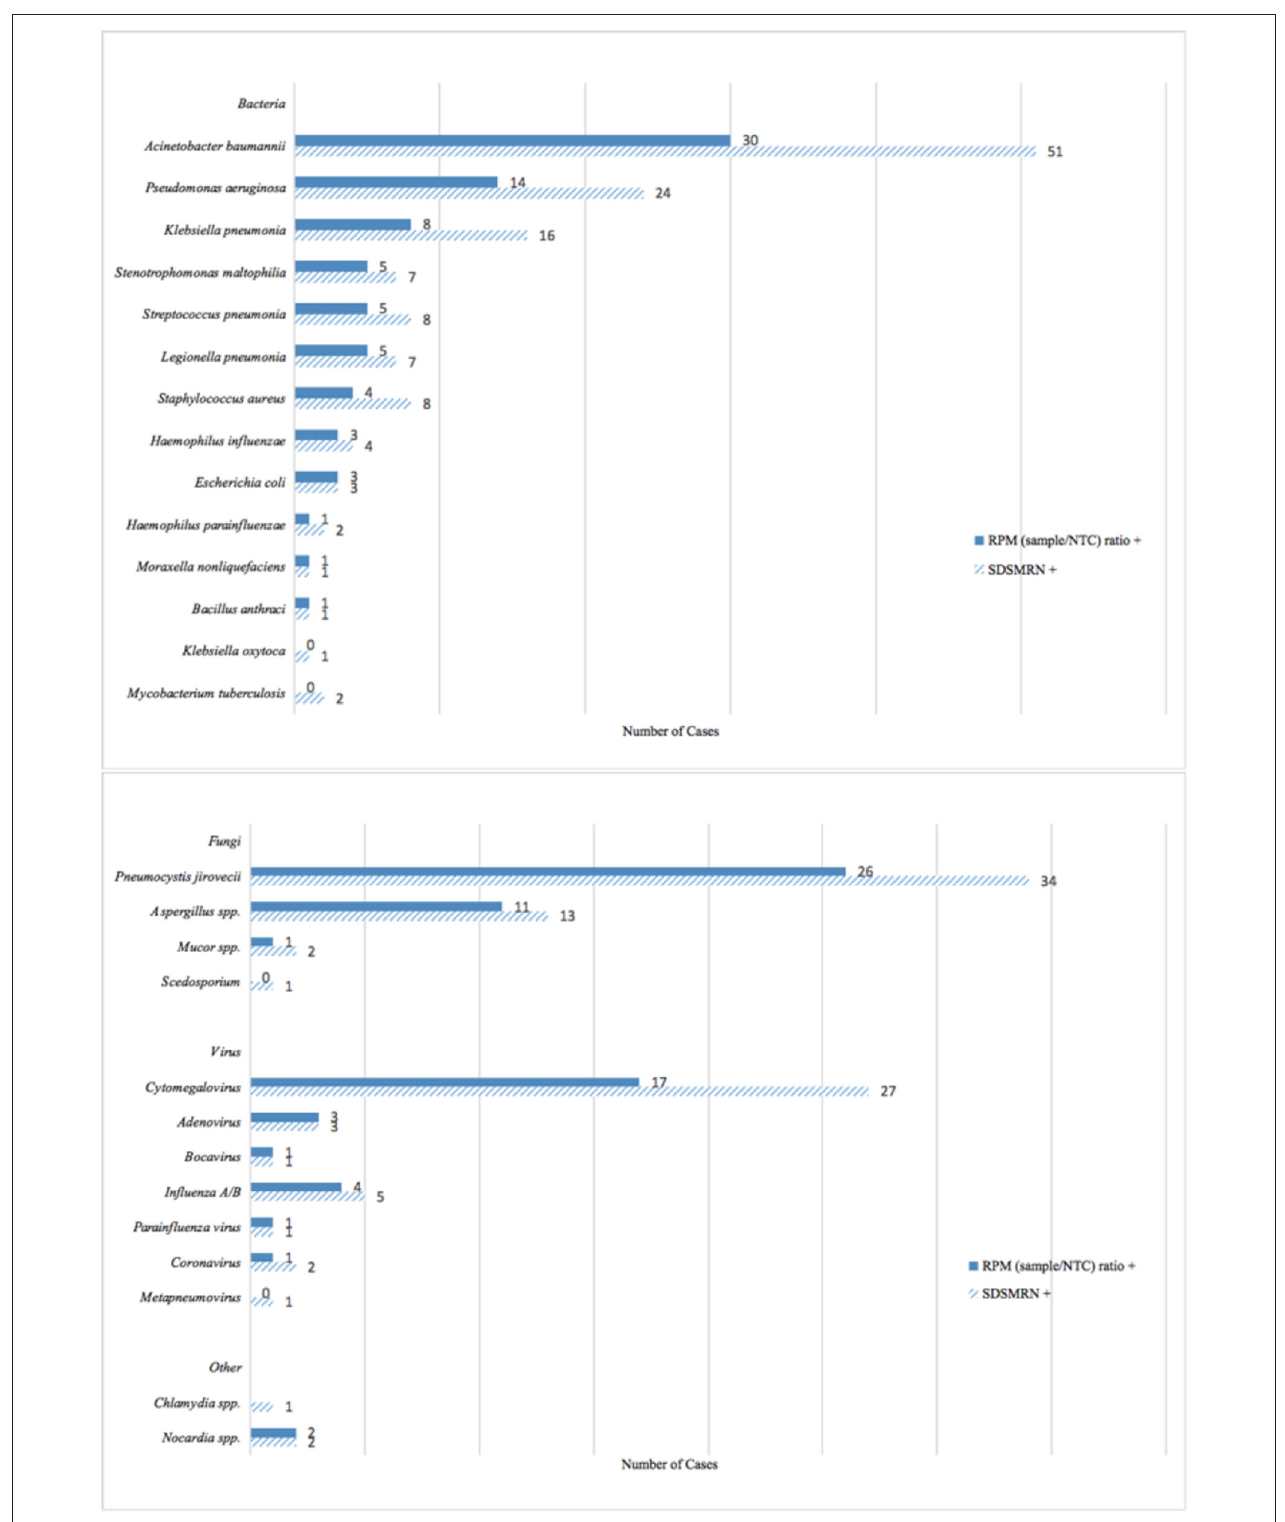
FIGURE 3 | Pathogen distribution according to metagenomic sequencing positive criteria of the reports of a total of 149 patients counted to the final analysis.